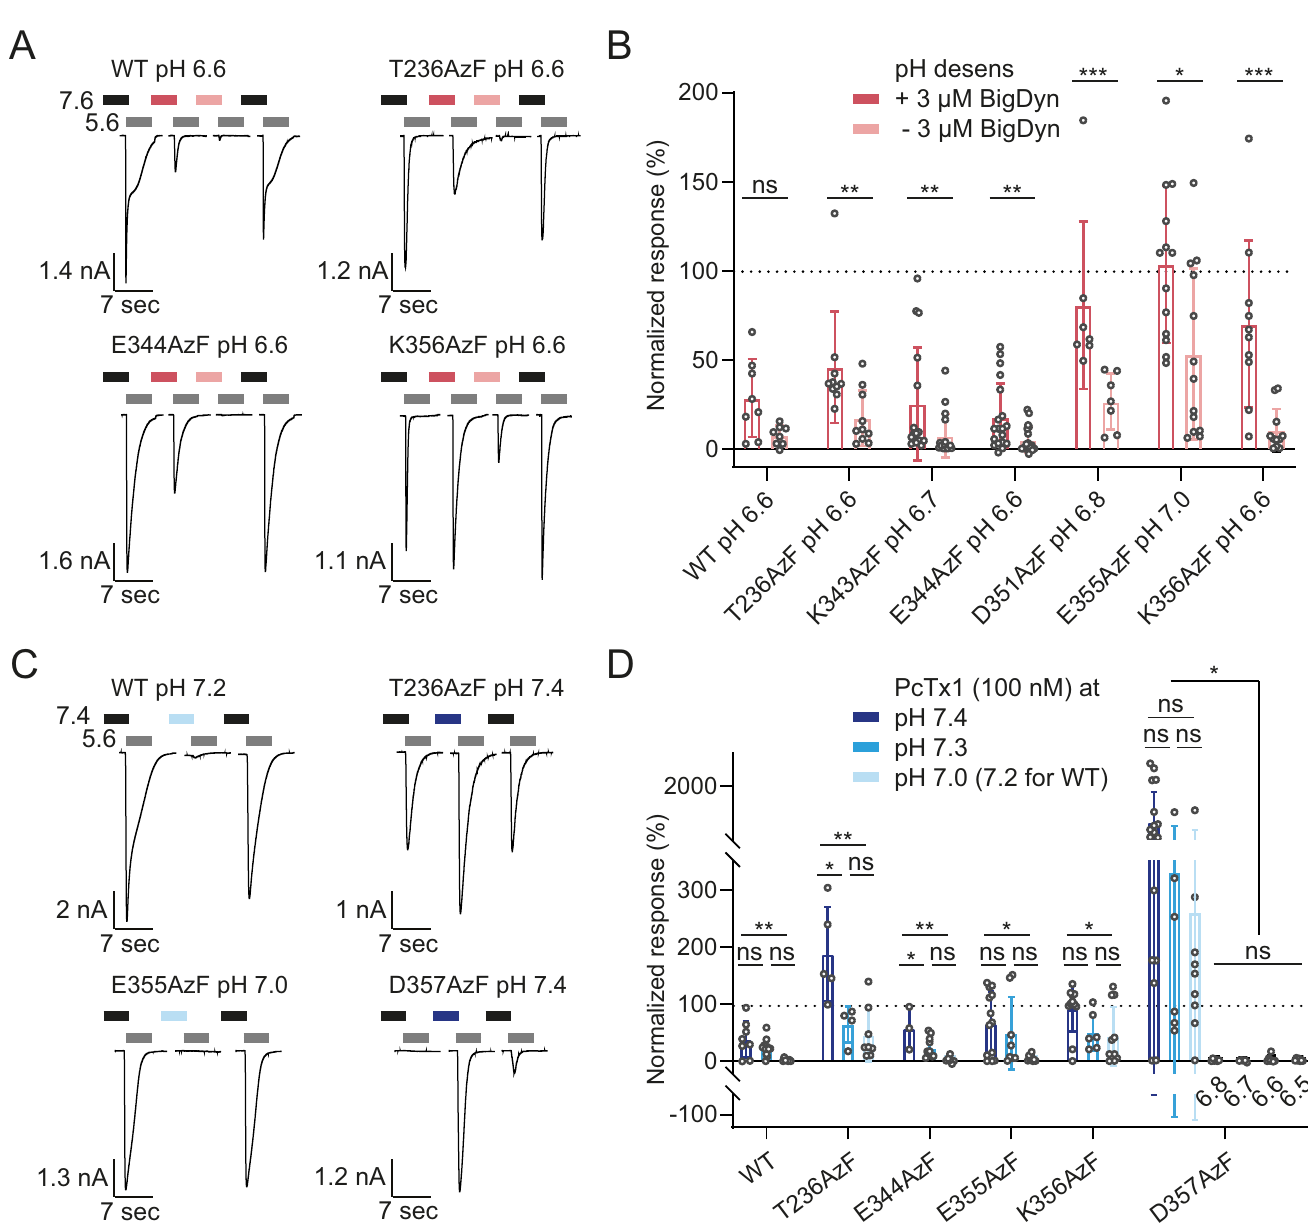
Fig 4. Peptide modulation of hASIC1a WT and selected variants containing AzF in the acidic pocket. (A) Characteristic current traces and (B) normalized response after SSD in absence or presence of BigDyn for hASIC1a WT and 6 ncAA variants. Cells were incubated at the desensitizing pH specified for each variant with or without 3 μ M BigDyn for 2 minutes (pink bars) before activation at pH 5.6 (gray bars, 5 seconds), and the currents were normalized to the average of 2 control currents after conditioning at pH 7.6 (black bars; control traces shown in S11 Fig). (C) Exemplary current traces and (D) bar graph for PcTx1 modulation of hASIC1a WT and selected variants containing AzF in the acidic pocket at different pH. Cells were incubated with 100 nM PcTx1 at varying pH for 2 minutes (blue bars) before activation at pH 5.6 (gray bars, 5 seconds), and the current was normalized to the average of the 4 preceding and following control currents after conditioning at pH 7.4 (black bars). Bar graphs show mean ± SD, dashed line indicates 100%, and values are shown in S5 and S6 Tables. ( � ) denotes significant difference between groups, p < 0.05; ( �� ): p < 0.01; ( ��� ): p < 0.001; ns: not significant; Mann–Whitney test (B) or 1-way ANOVA with Tukey multiple comparisons test (D). Colored and black bars in (A) and (C) not to scale. The underlying data have been deposited at zenodo.org (https://doi.org/10.5281/zenodo.4906985; files 11, 12, 34, and 35). AzF, 4-Azido-l-phenylalanine; BigDyn, big dynorphin; hASIC1a, human acid-sensing ion channel 1a; ncAA, noncanonical amino acid; PcTx1, psalmotoxin 1; SD, standard deviation; SSD, steady-state desensitization; WT, wild